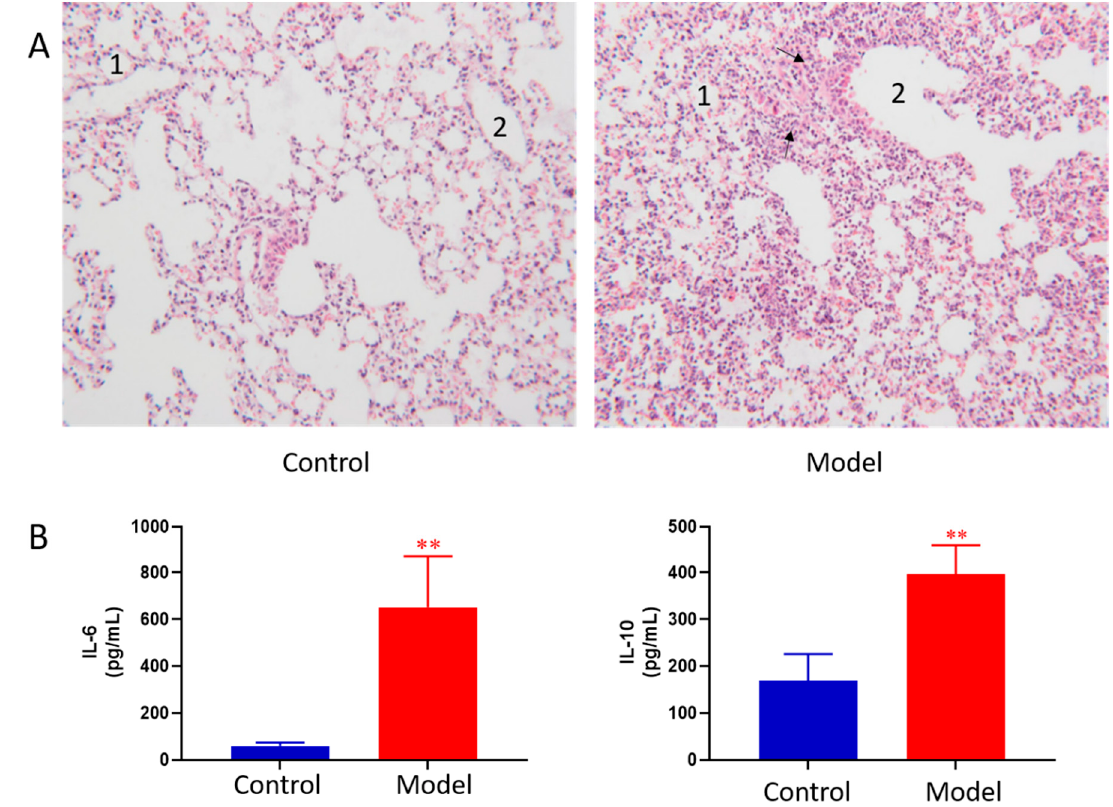
Figure 1. Pathological change of lung tissue of control and ALI model mice (HE × 100) 1, alveolar; 2, trachea; The black arrows indicate increased numbers of pulmonary macrophages and neutrophils ( A ), BALF cytokines of the control and ALI model mice. Values are expressed as mean ± SD. ( n = 4), ** p < 0.01 vs. control mice ( B ).